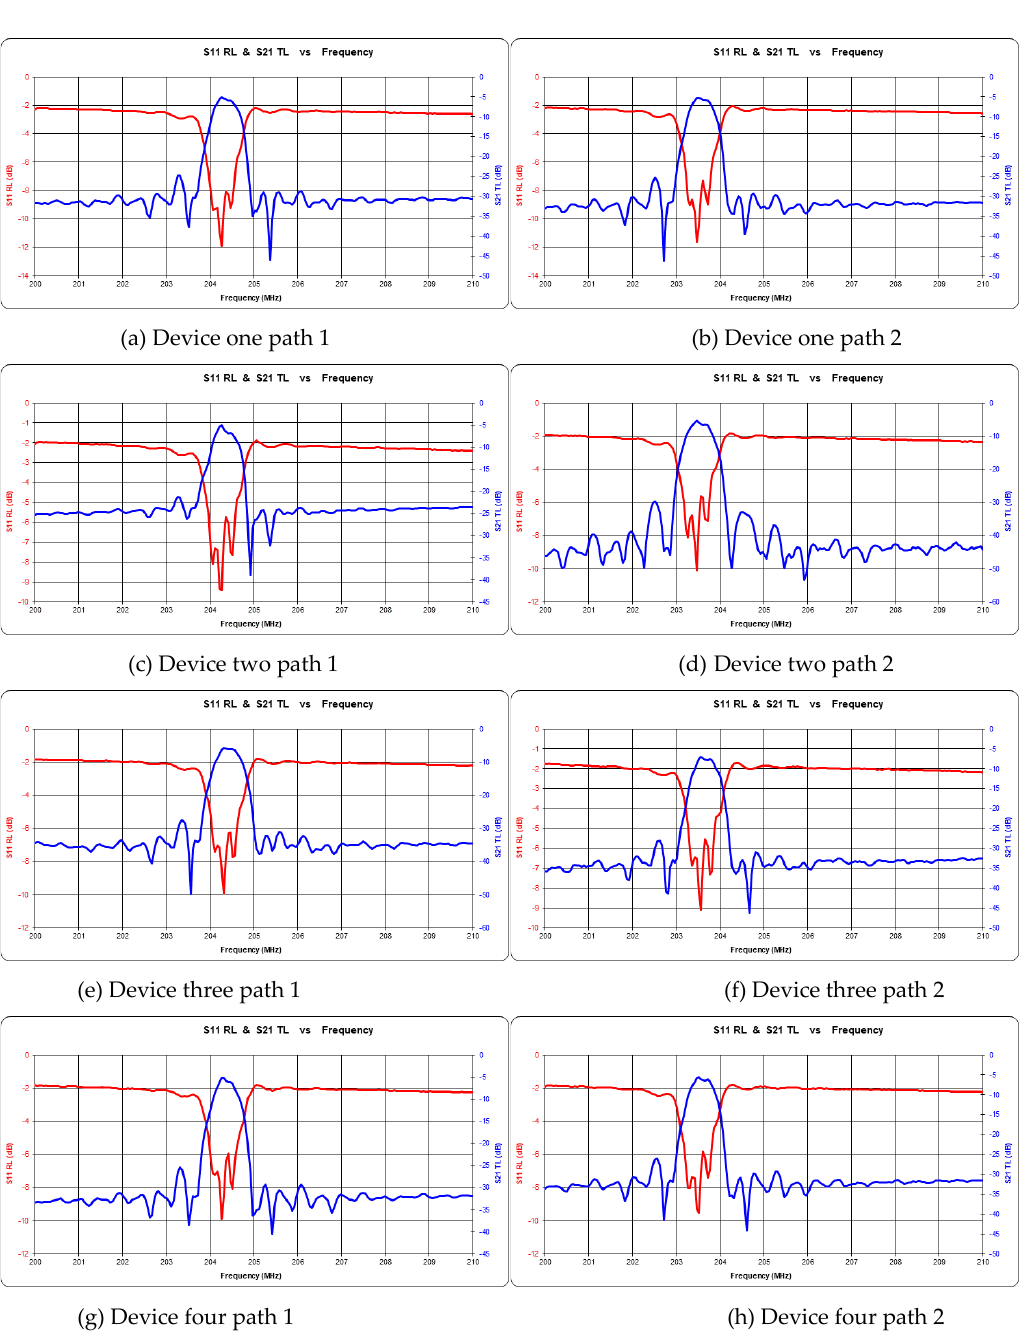
Table 1. Sensor conformance test center frequency table.